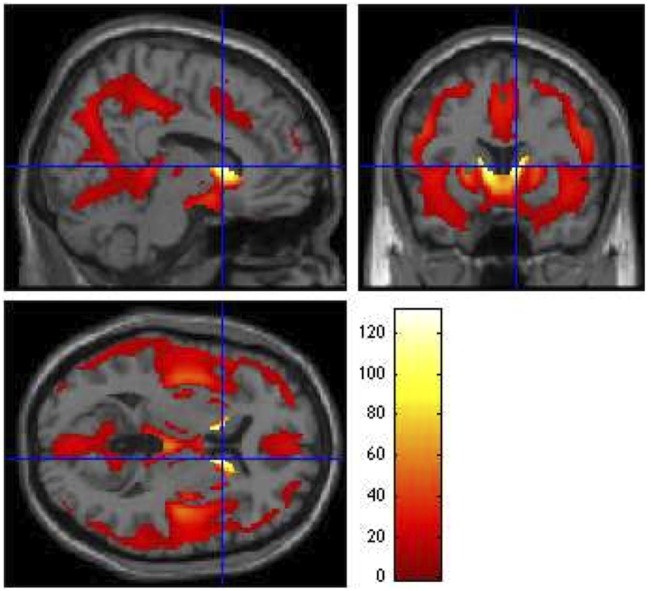
Group main effects (ANCOVA F contrast). Main effects of CAP group on VBM, showing regions that vary throughout the prodrome (p ≤ 0.05). Global maximum: x = 10.00, y = 12.00, z = 6.00; F3,992 = 131.13. The colored bar legend codes the F statistic at each voxel, with white areas denoting voxels with the highest significance levels.